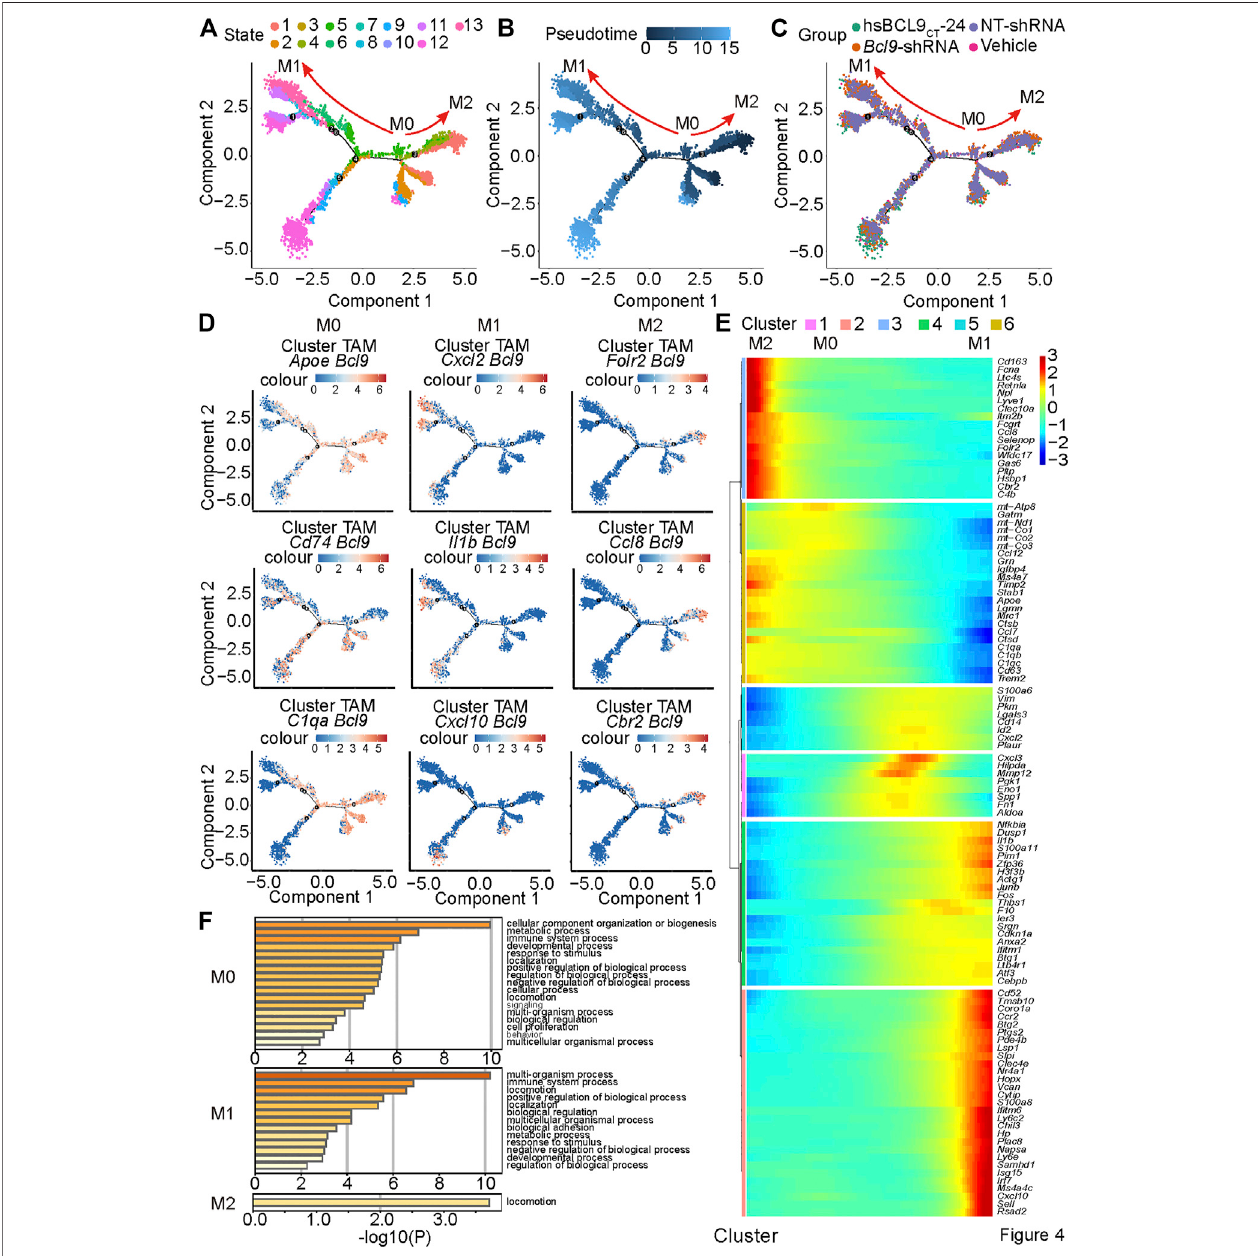
FIGURE 4 | Pseudotime analysis reveals the trajectory of M0, M1 and M2 in mouse CT26 tumor. Pseudotime analysis on the TAM cells of clusters 0, 2 and 4 in Figure3C and (A) States; (B) Pseudotime; (C) groups(vehicle,hsBCL9 CT -24,NT-shRNA, Bcl9 -shRNA); (D) M0,M1andM2markerGeneexpression level; (E) trendof the gene expression generated by the BEAM function along pseudotime. (F) Metascape biological processes enrichment analysis by using gene clusters abtained from BEAM function.